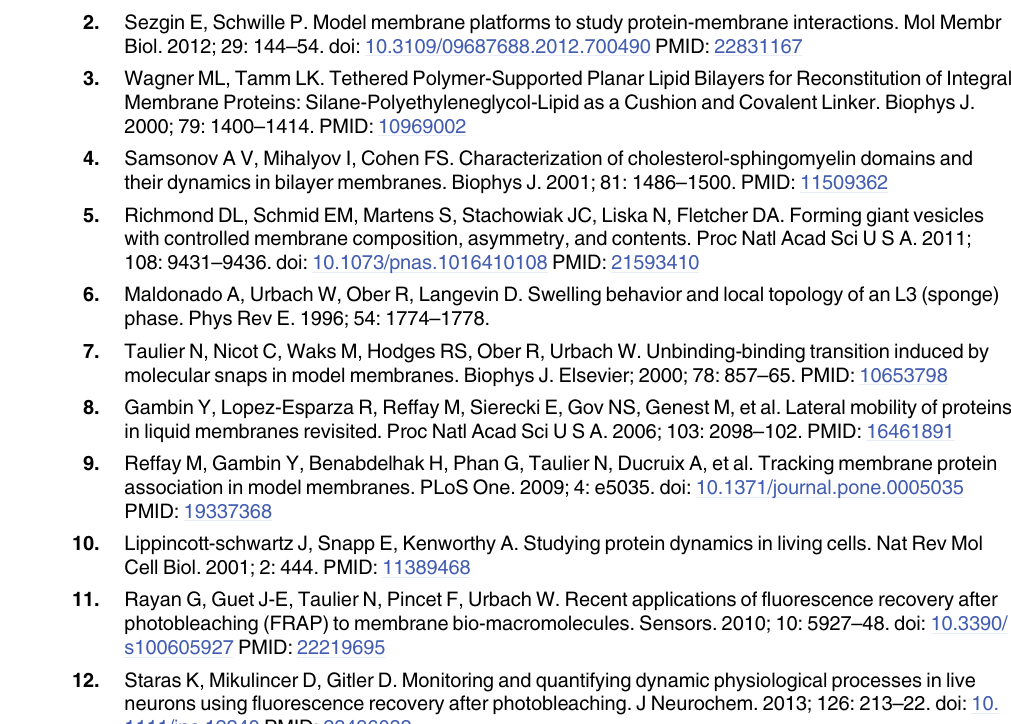
arbitrarily de fi ned as the cases where < (cid:2) t 1 > , < (cid:2) t 2 > and < from the theoretical values, and all normalized standard deviations are lower than